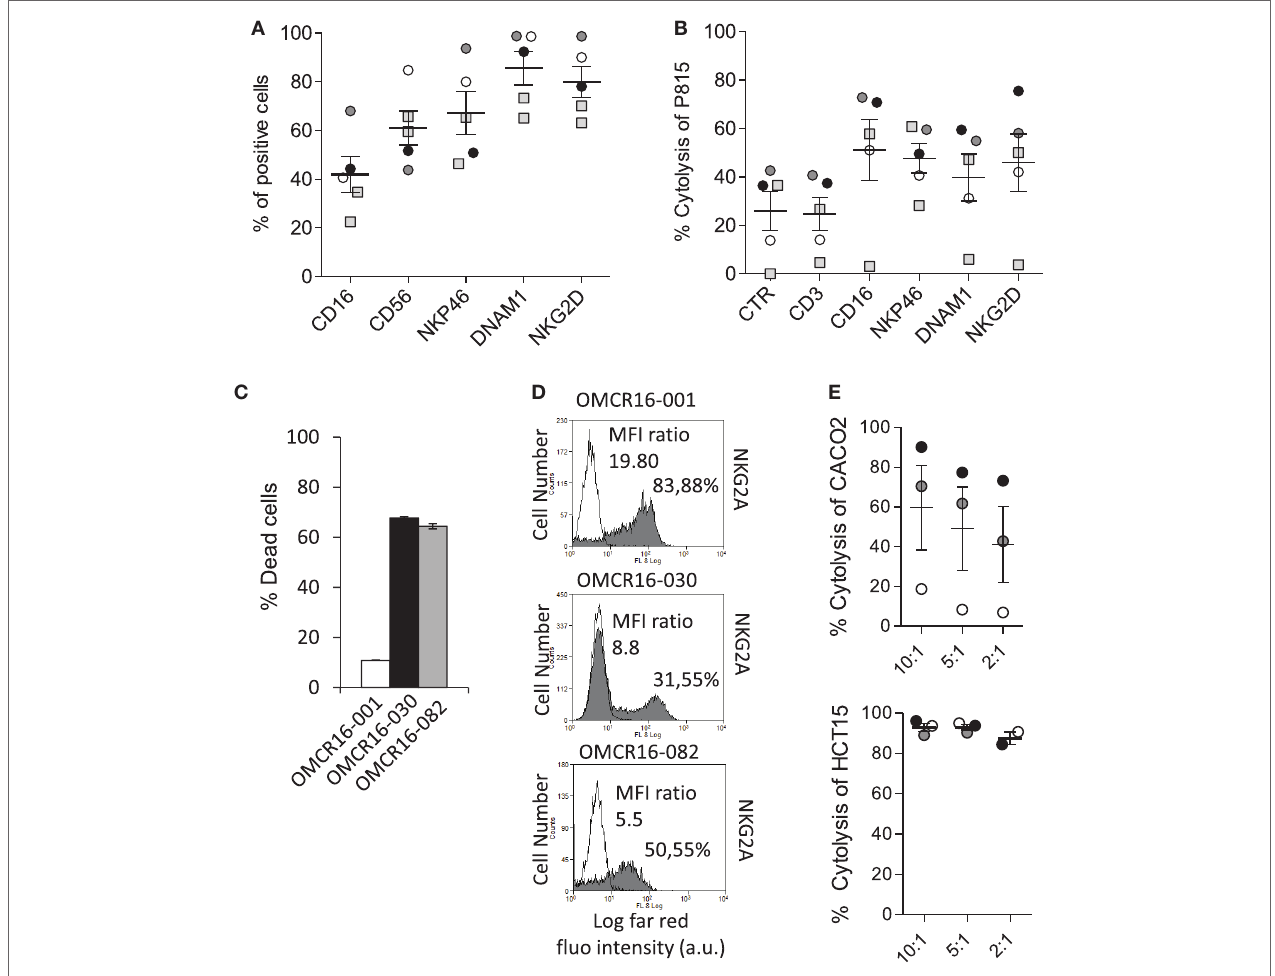
FigUre 6 | Sorted NKp46 + CD3 − cells from CRC give rise to natural killer (NK) cells with anti-tumor-associated fibroblasts (TAF) and antitumor activity. (a) Phenotype of cell suspensions from five CRC, by immunofluorescence with monoclonal antibodies (mAbs) against the indicated molecules (CD16, CD56, NKp46, DNAM1, and NKG2D) followed by anti-isotype APC-goat anti-mouse (GAM) antiserum and FACS analysis. Results are expressed as percentage of positive cells. Mean ± SEM of the five cases is shown. (B) Sorted NKp46 + CD3 − cells of 5 CRC, expanded with IL-2, were assayed in redirected killing (ATCC) against P815, in a 51 Cr release assay, using mAbs recognizing CD16, NKp46, DNAM1, and NKG2D (CD3 was used as negative control). Results are expressed as percentage of P815 cell lysis. Mean ± SEM of the five cases is shown. (c) NKp46 + CD3 − cell populations from three CRC [OMCR16-030, OMCR16-082, and OMCR16-001, black, gray, and white, respectively, as the circles in panels (a,B) ] were co-cultured for 24 h with autologous TAF at the ratio of 10:1 (NKp46 + CD3 − / TAF); then TAF viability was assessed by crystal violet assay and results expressed as percentage of dead cells. Mean ± SEM of triplicate samples is shown. (D) Expression of NKG2A by indirect immunofluorescence with the specific mAb (gray histograms), followed by isotype-specific APC-GAM and FACS analysis, on OMCR16-001, OMCR16-030, and OMCR16-082 NKp46 + CD3 − cells. White histograms: negative control with APC-GAM alone. Results are expressed as log far-red fluorescence intensity (a.u.) vs number of cells. In each quadrant: percentage of positive cells and MFI ratio (MFI gray/MFI white histograms, a.u.). (e) Cytolytic activity of NKp46 + CD3 − cell populations from OMCR16-030, OMCR16-082, and OMCR16-001 (black, gray, and white circles, respectively) against the HLA-I + Caco2 (upper graph) or the HLA-I − HCT15 (lower graph) CRC cell lines, in a 51 Cr release assay. Results are expressed as percentage of specific cytolysis. Mean ± SEM of the three cases is